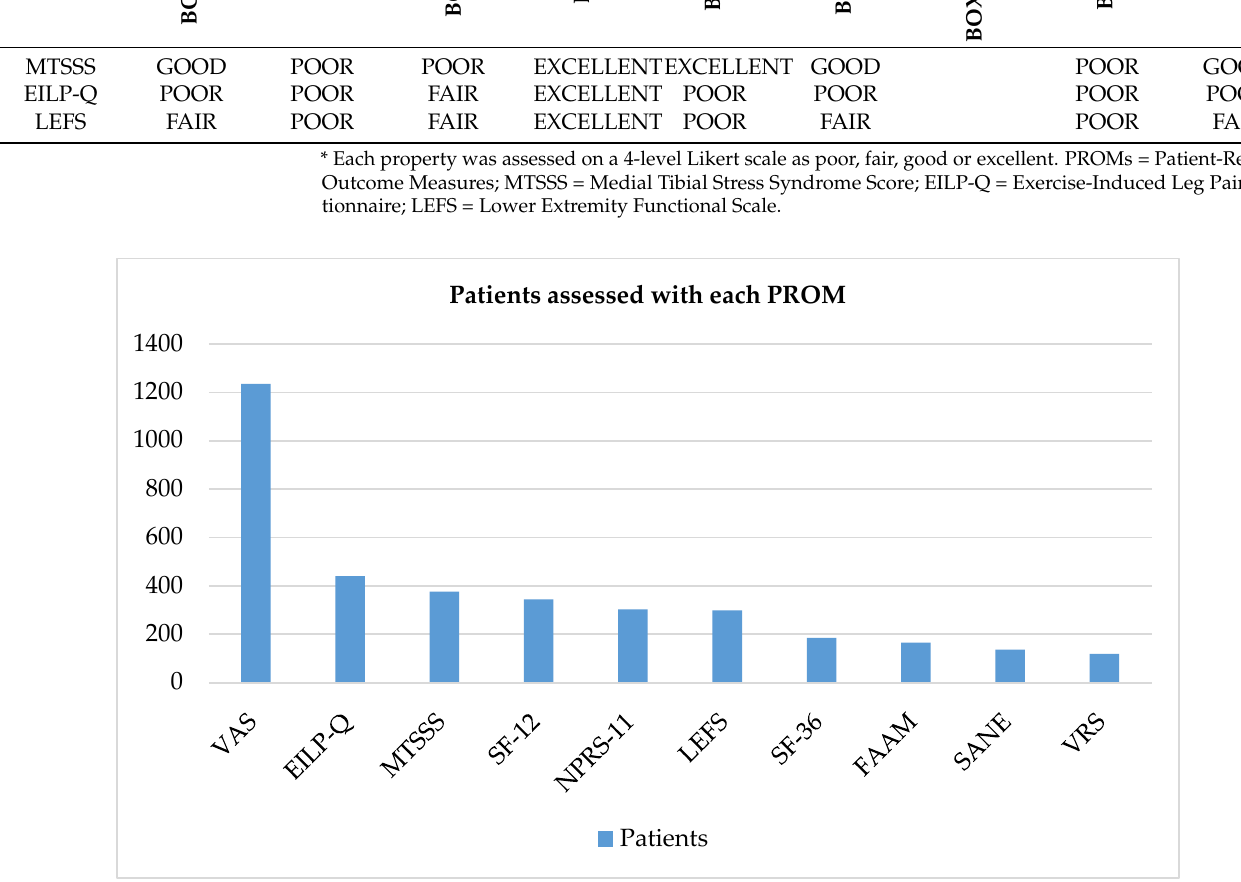
Figure 2. Number of patients assessed with each PROM.PROM = Patient-Reported Outcome Measures; VAS = Visual Analog Scale; MTSSS = Medial Tibial Stress Syndrome Score; EILP-Q = Exercise-Induced Leg Pain Questionnaire; NPRS-11 = Numerical Pain Rating Scale-11; LEFS = Lower Extremity Functional Scale; FAAM = Foot and Ankle Ability Measures; SANE = Single Assessment Numeric Evaluation; SF-12 = Short Form-12; SF-36 = Short Form-36 (SF-36) and VRS = Verbal Rating Scale.